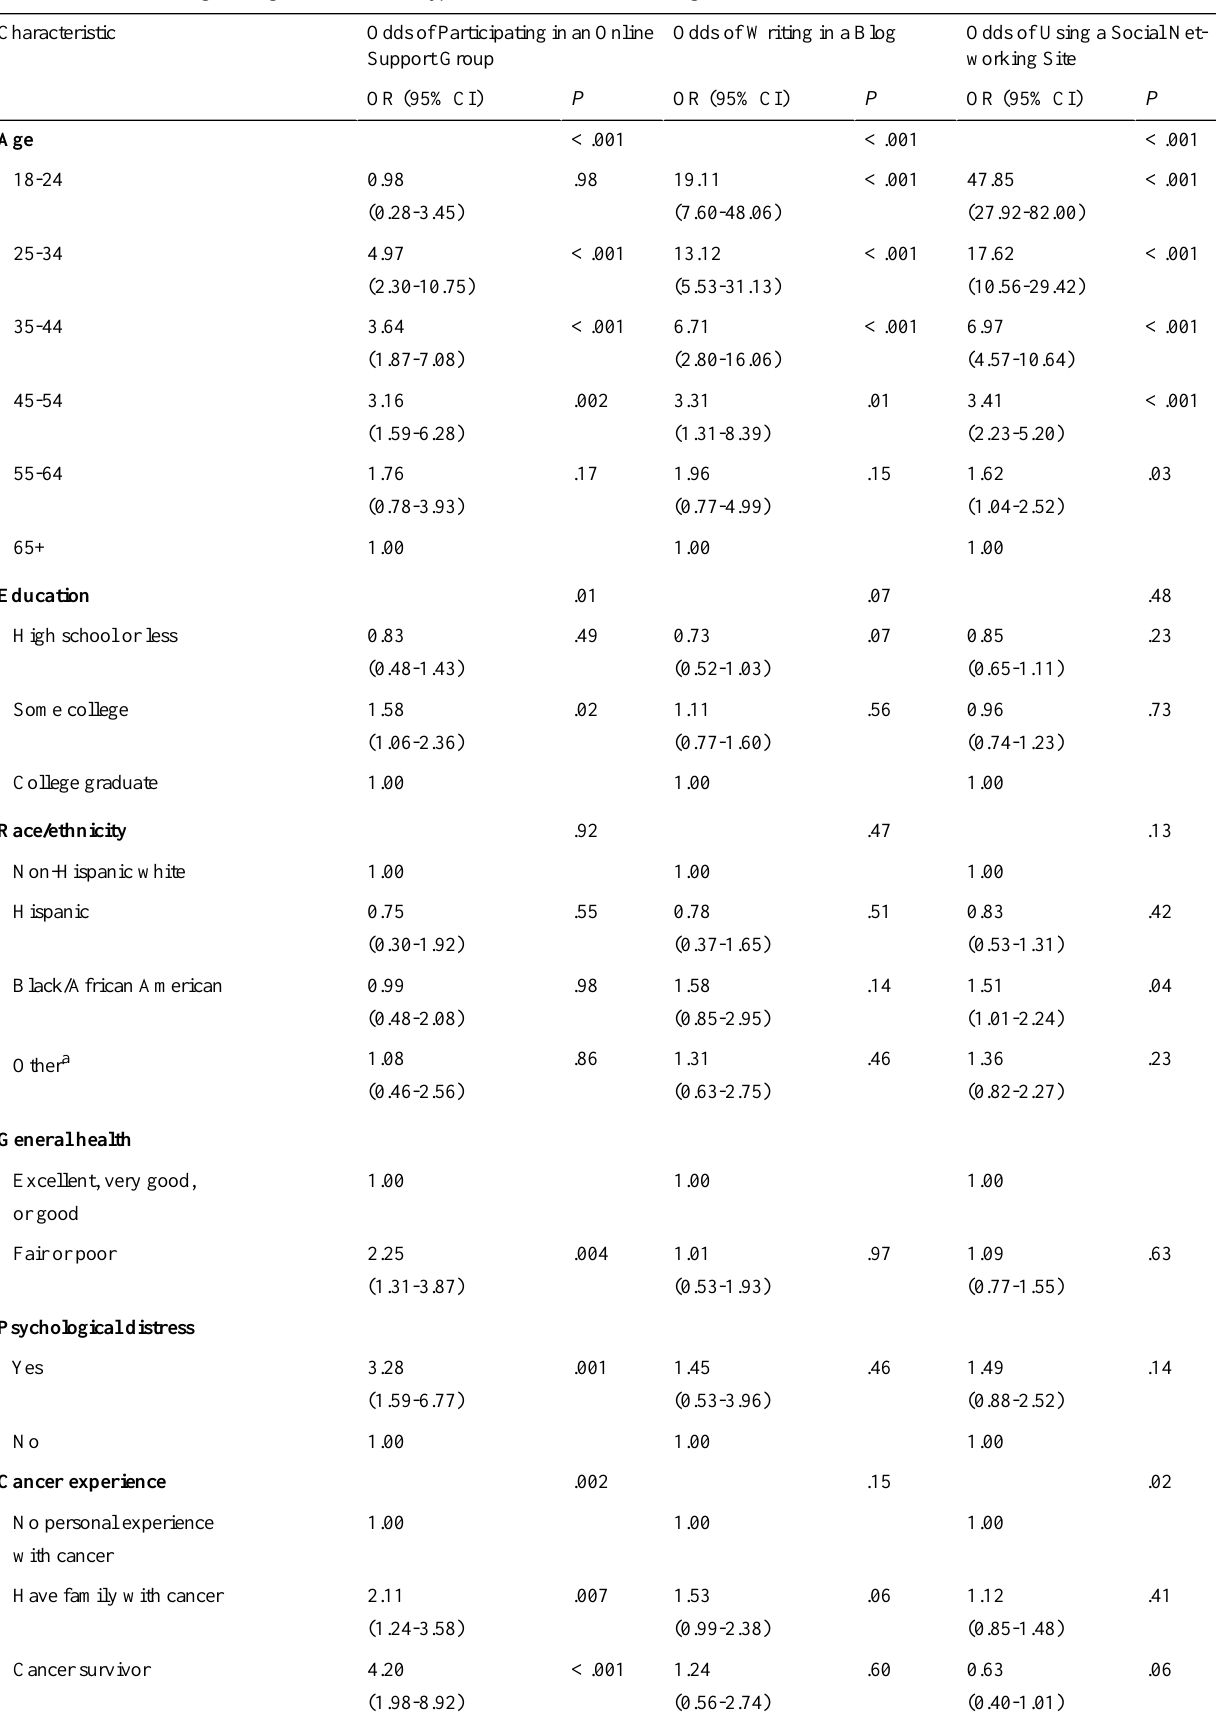
SiteOdds of Writing in a BlogOdds of Participating in an Online